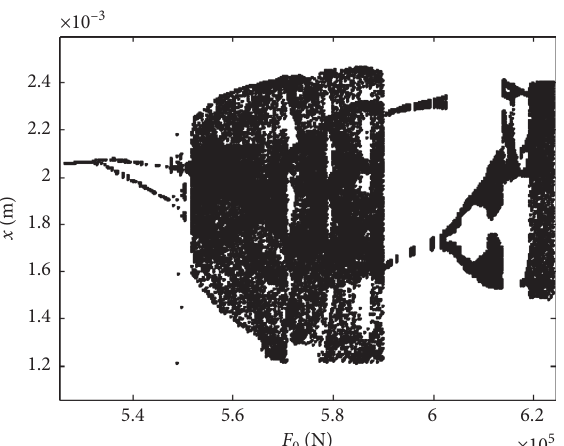
Figure 13: Bifurcation diagram of horizontal vibration of the hot rolling mill rolls under varying external excitation amplitude.